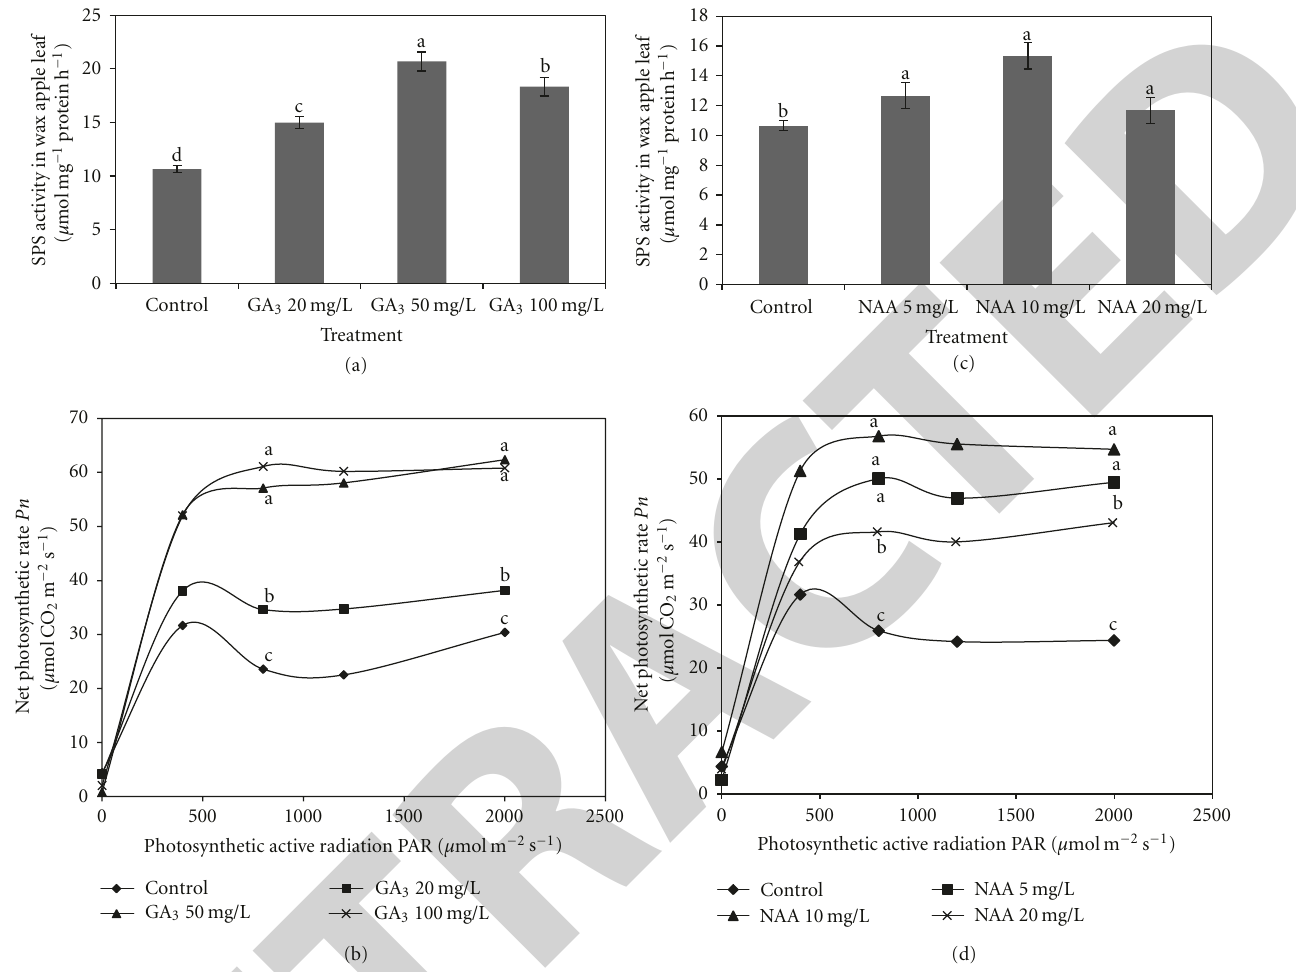
Figure 5: E ff ect of GA 3 treatment on (a) SPS activity, (b) net photosynthesis and NAA treatment on (c) SPS activity, and (d) net photosynthesis of wax apple leaves. Data are means of six replicates ± SE. Di ff erent letters represent the significance at the 5% level of LSD